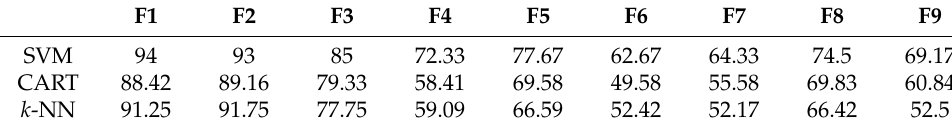
Table 7. The performances of models utilizing the F1 to F9 features set.